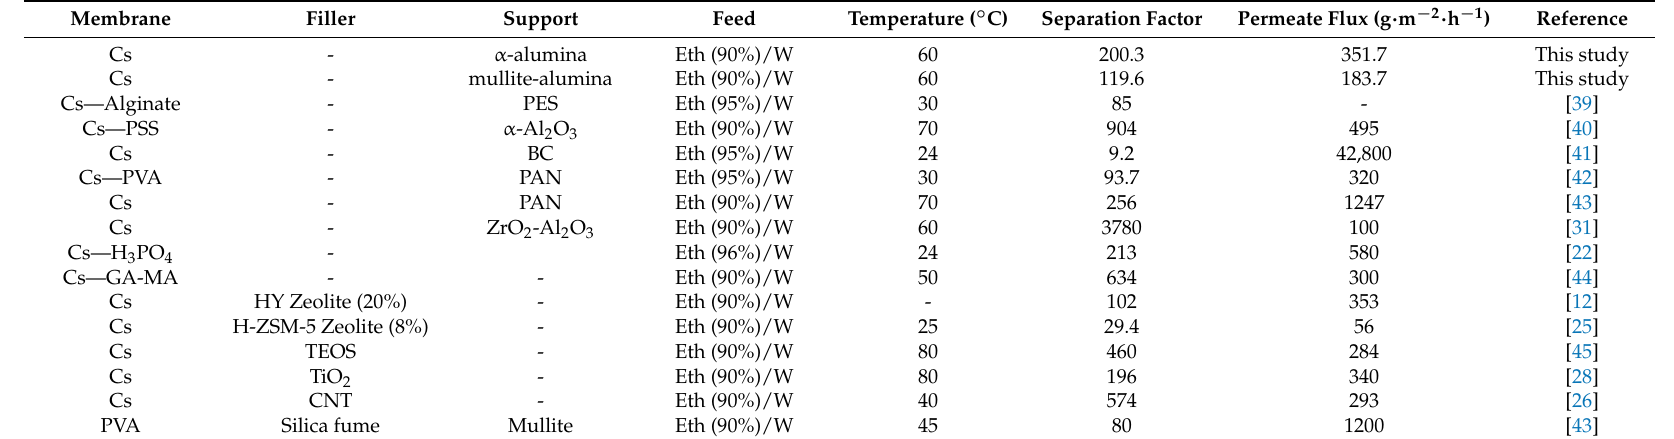
Table 4. The comparison between synthesized membranes in this study with the